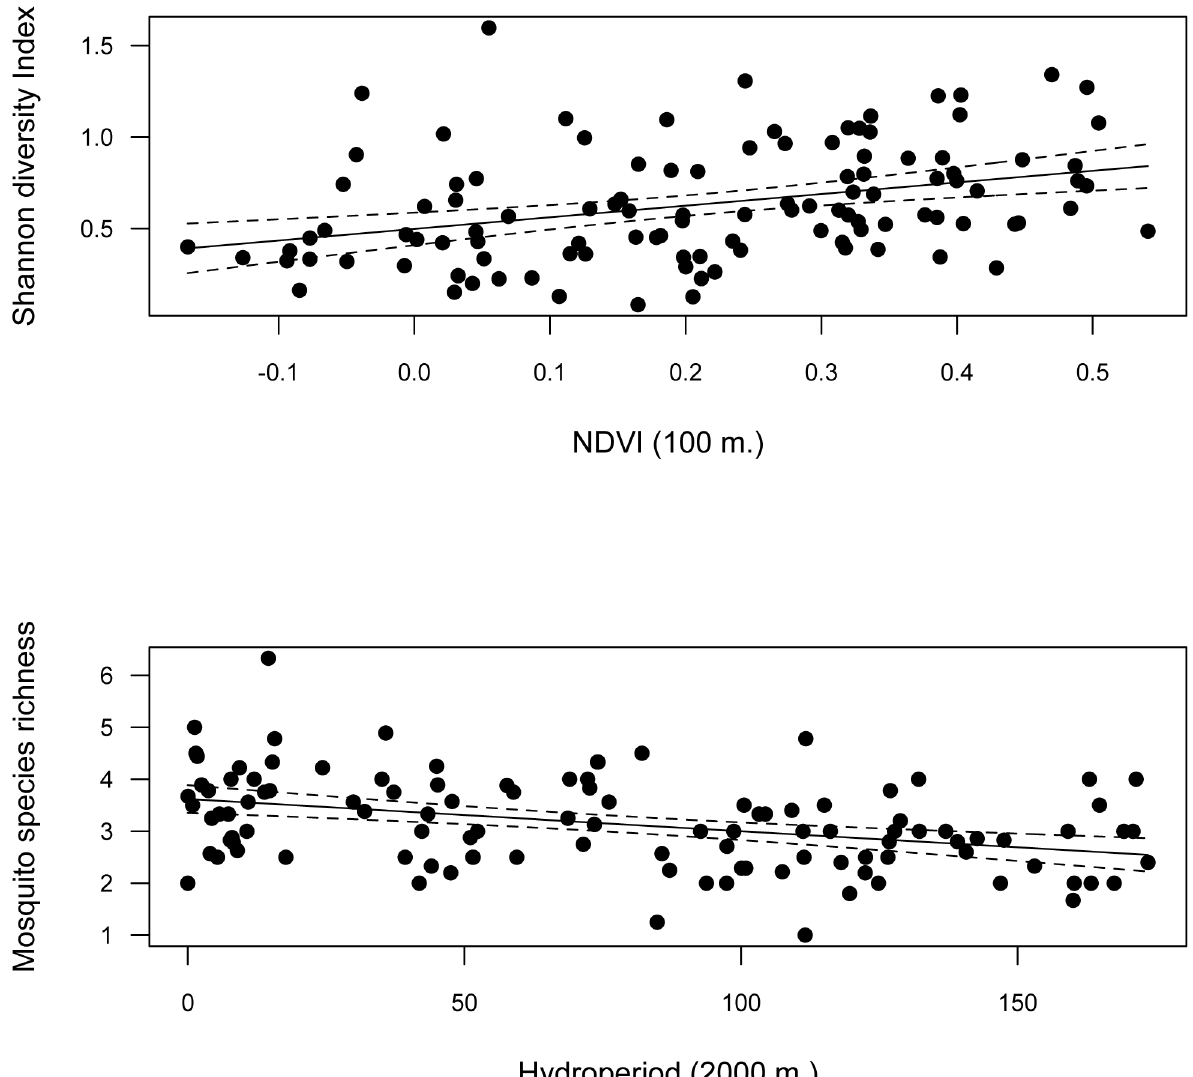
Fig 5. Relationships among annual hydroperiod, NDVI and Shannon diversity index and mean annual mosquito species richness.